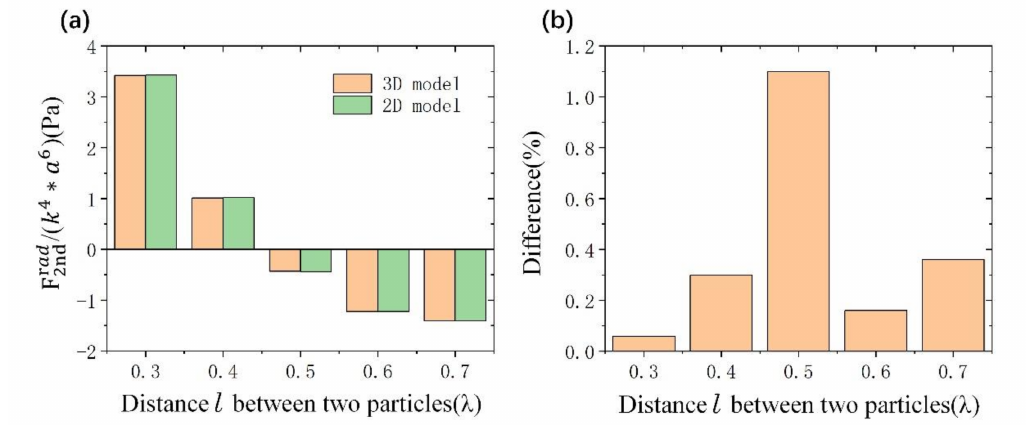
Figure 3. ( a ) Normalized force calculated by two methods. ( b ) Di ff erence between the results of the two methods